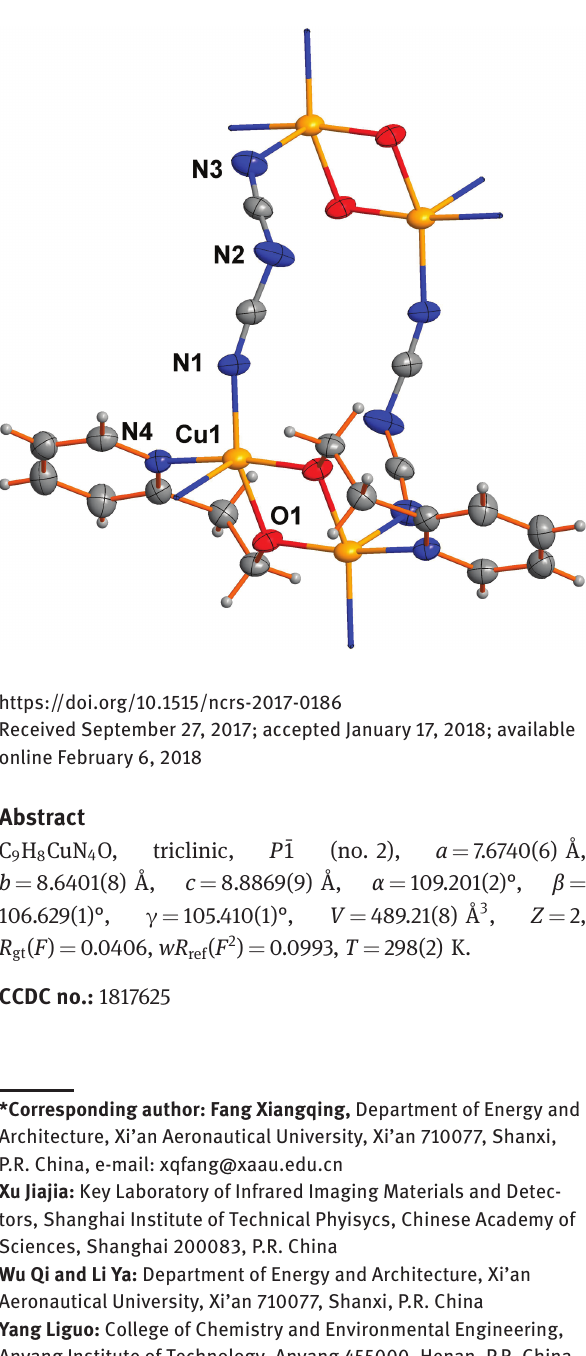
figure. Table 1 and Table 2 contain details on crystal structure andmeasurement conditions anda list of the atoms including atomic coordinates and displacement